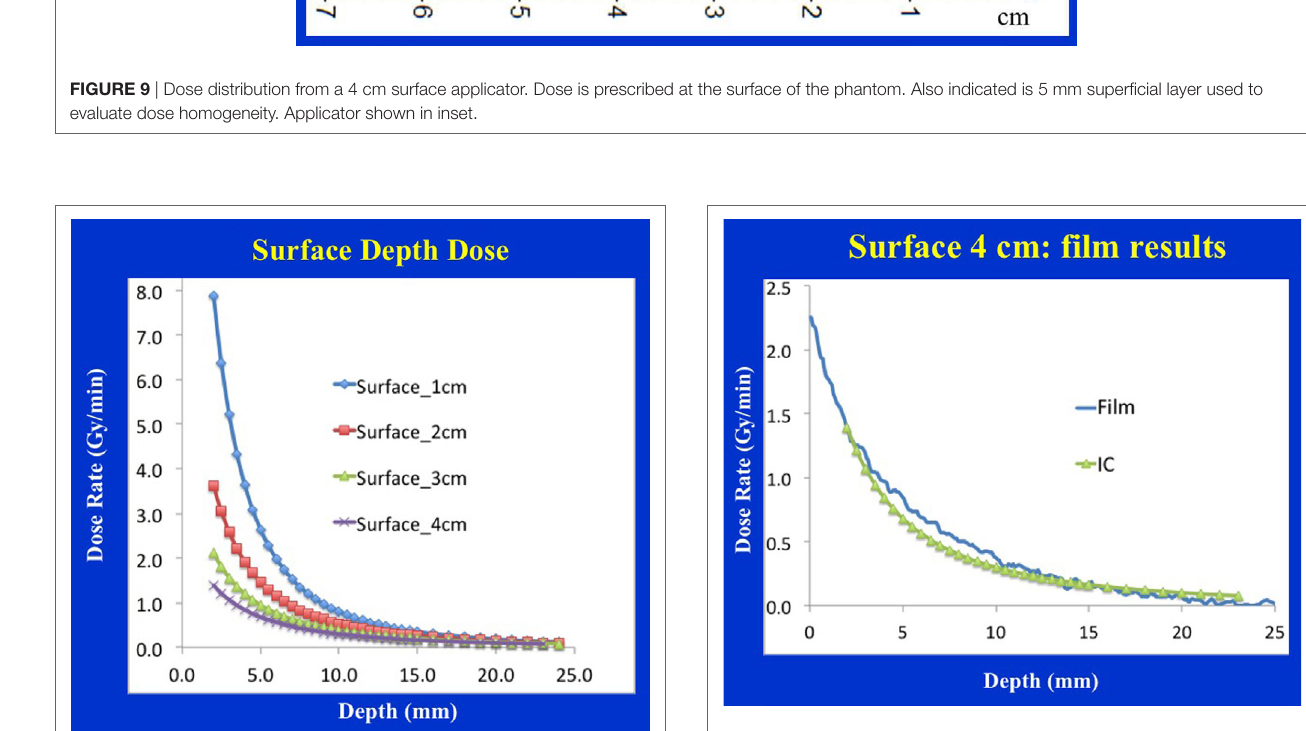
FigUre 11 | Film vs. ion chamber depth dose comparison for a 4 cm diameter surface applicator. Discrepancy between film and ion chamber data could be related to X-ray spectral changes resulting from steep dose gradient associated with surface applicators.